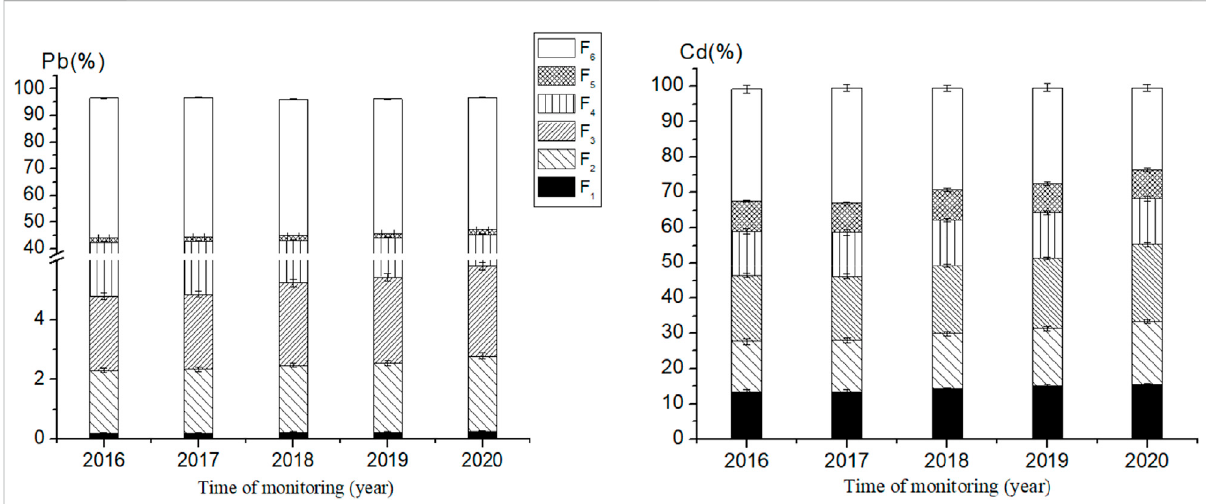
FIGURE 3 RelativeabundancesofPbandCdintheexchangeable(F 1 ),adsorbed(F 2 ),fulvicandhumiccomplex(F 3 ),reducible(F 4 ),organic(F 5 ),andresidual (F 6 ) fractions following the sequential extraction procedure of the